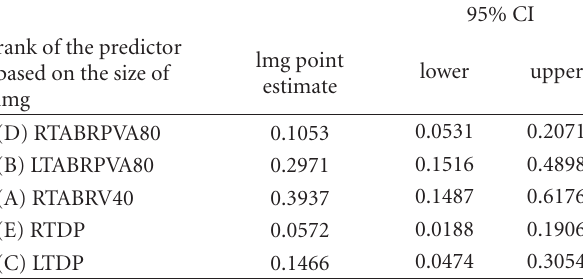
Table 3: Relative importance 95% confidence intervals (95%